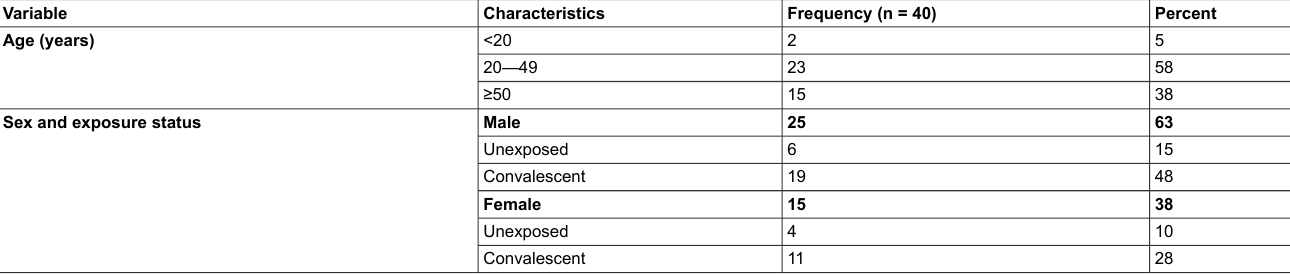
Table 1: Cohort characteristics.